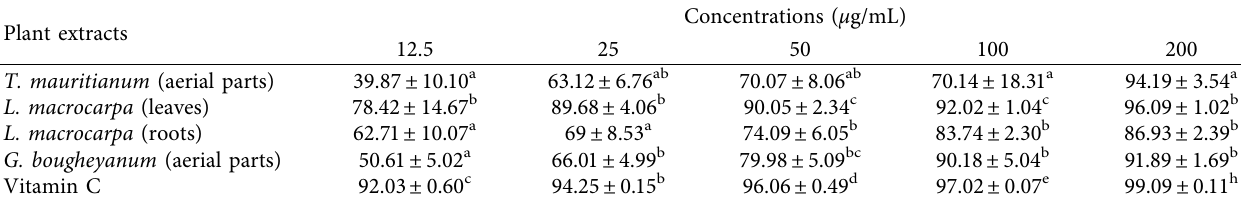
Table 5: Nitric oxide scavenging activity of plant extracts as a function of